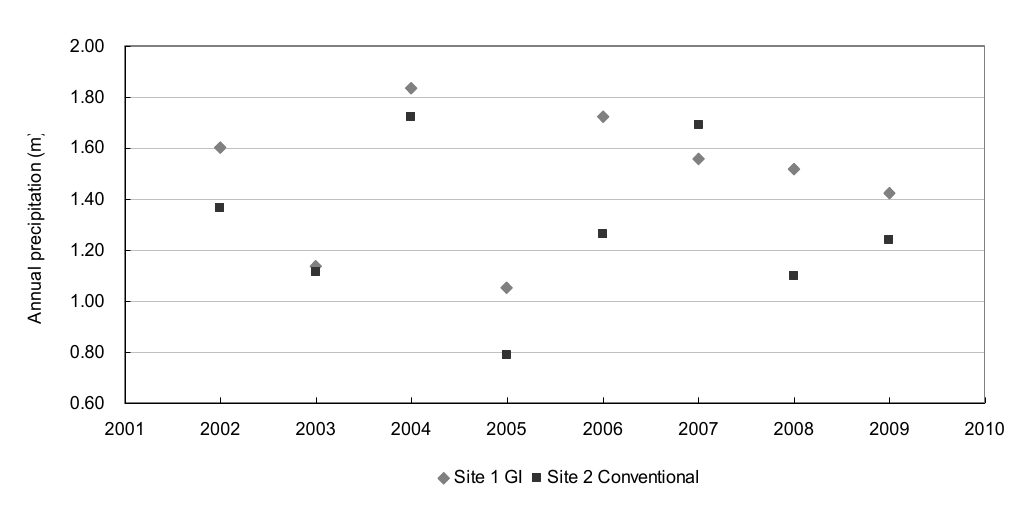
Figure 8. Annual precipitation in Site 1 (Panther Creek watershed, The Woodlands green infrastructure development) and Site 2 (Bear Creek watershed, conventional development), 2002–2009.